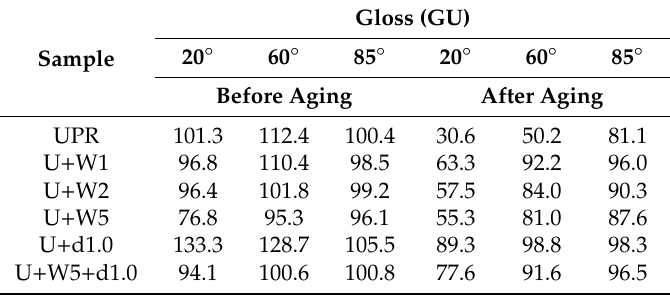
Table 5. Gloss measurement data of green composites before and after the accelerated aging test.